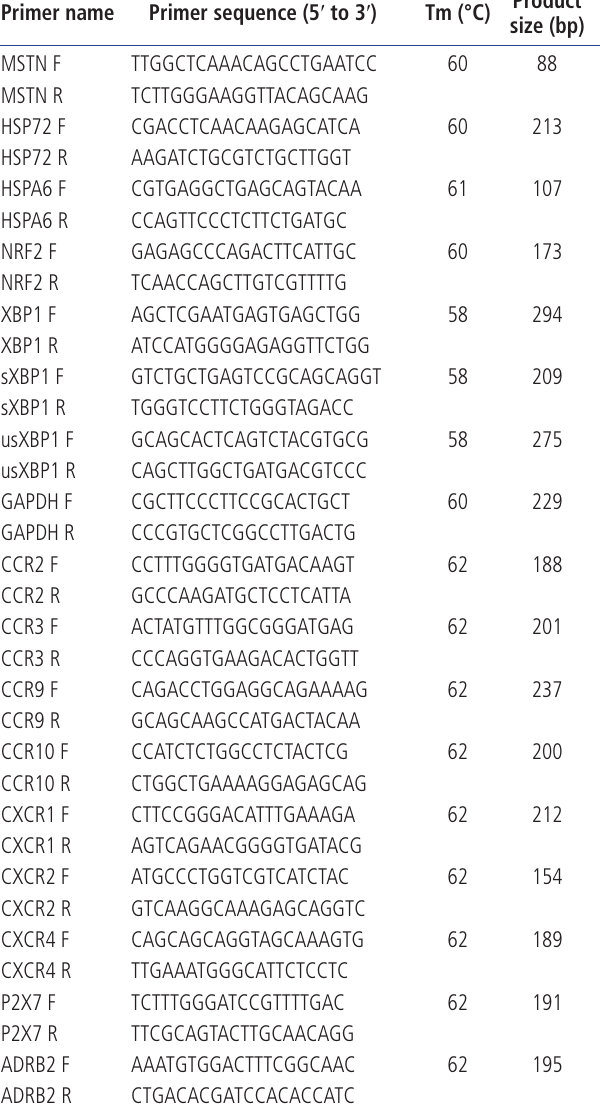
Table 1. Primer sets used in this study Primer name